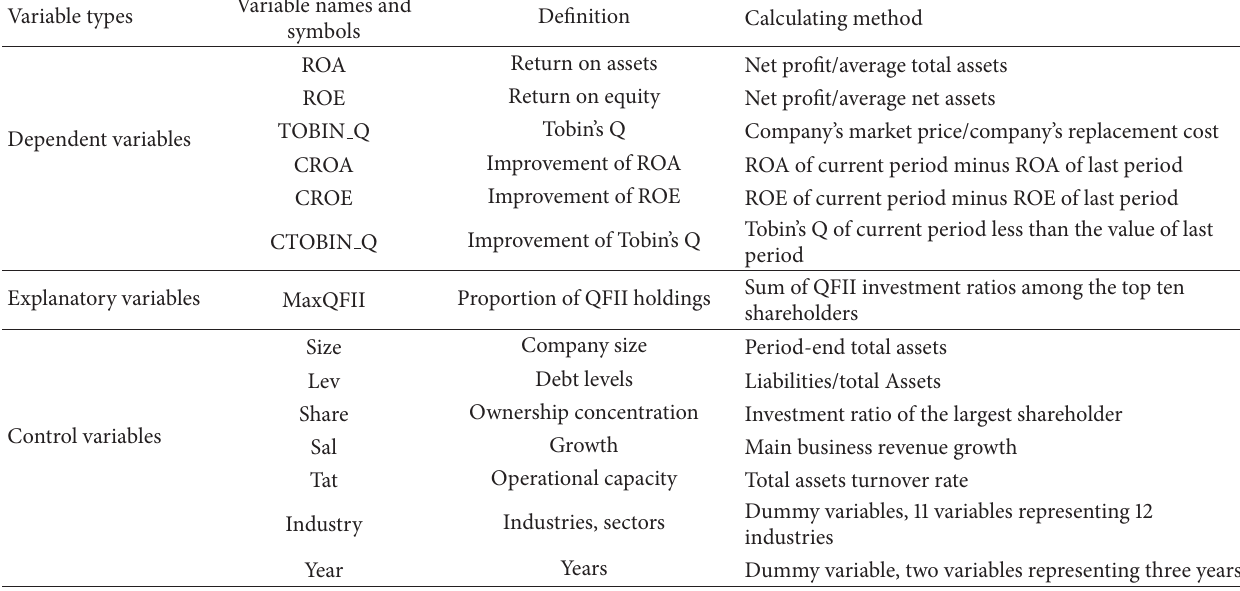
Table 1: List of study